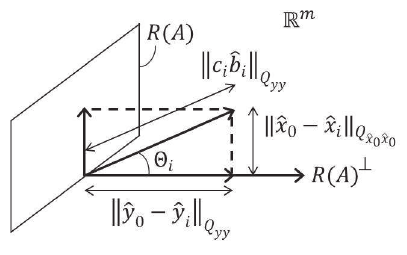
= || ˆ y − ˆ y || 2 + 0 i Q yy Q yy